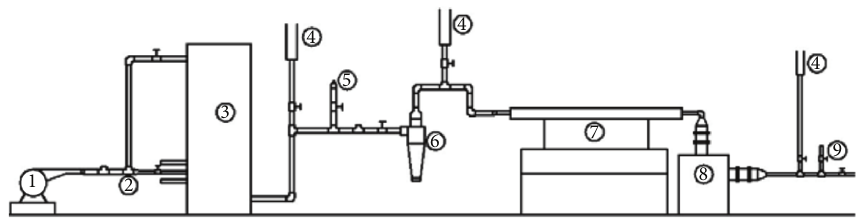
Figure 1: Schematic of the experimental setup: (1) air blower, (2) air distribution line, (3) downdraft gasifier, (4) gas flare points, (5) raw gas sampling point, (6) cyclone for gas cleaning, (7) cooling heat exchanger, (8) oil bath filter, and (9) clean gas sampling